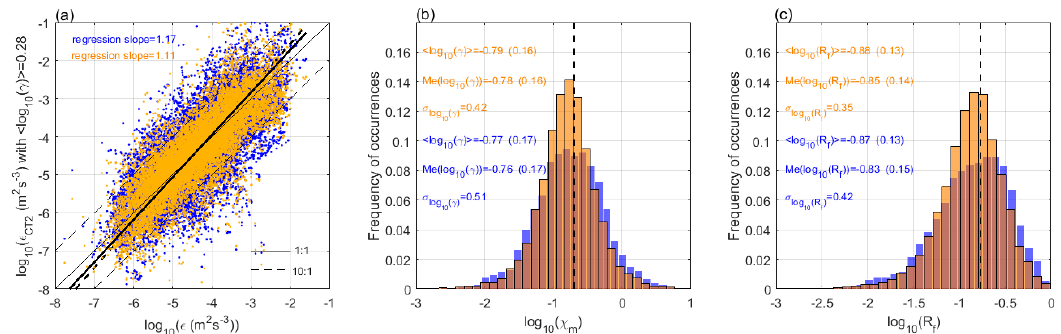
Figure 8. ( a ) Scatter plot of 𝑙𝑜𝑔 (cid:2869)(cid:2868) (𝜀) vs 𝑙𝑜𝑔 (cid:2869)(cid:2868) (𝜀 (cid:3004)(cid:3021)(cid:2870) ) estimated from 𝐶 (cid:3021)(cid:2870) using Equation (6) and < 𝑙𝑜𝑔 (cid:2869)(cid:2868) (𝛾) >= 0.28 with measured 𝑁 (cid:2870) (brown) and with 𝑁 (cid:2870) = 1.47 10 (cid:2879)(cid:2872) rad (cid:2870) s (cid:2879)(cid:2870) (blue). Thick dashed and solid lines show the corresponding regression lines. ( b ) Histogram of mixing efficient coefficient 𝜒 (cid:3040) . The vertical dashed line shows 𝜒 (cid:3040) = 0.2 ( c ) Histogram of flux Richardson number 𝑅 (cid:3033) . The vertical dashed line shows 𝑅 (cid:3033) = 0.17